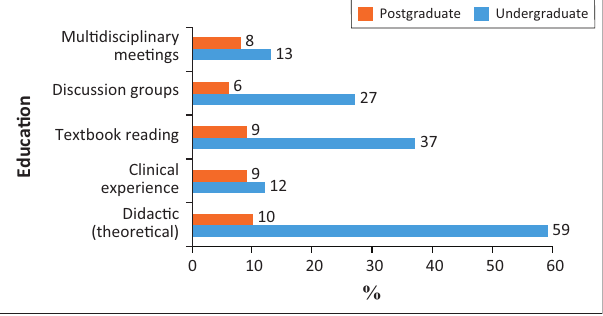
FIGURE 3: Undergraduate and postgraduate academic education in cleft lip/ palate/craniofacial deformities patient management.